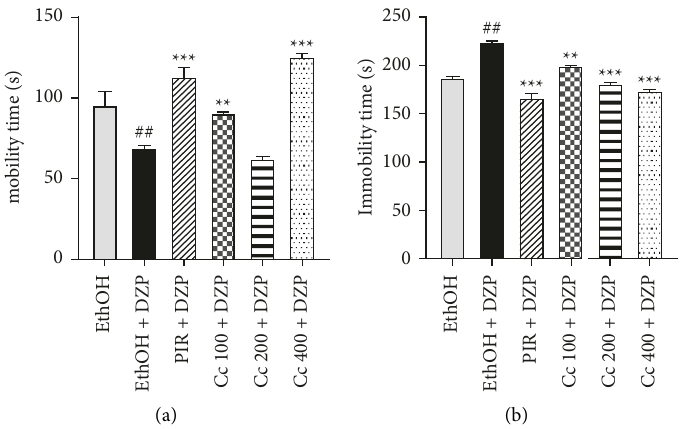
Figure 2: Effects of ethanolic leaf extract of Cc in memory evaluated by the Novel Object Recognition test. Bars represent the mean n 5. DZP diazepam, PIR (cid:31) (cid:31) ### p 0001 vs. normal control group. <